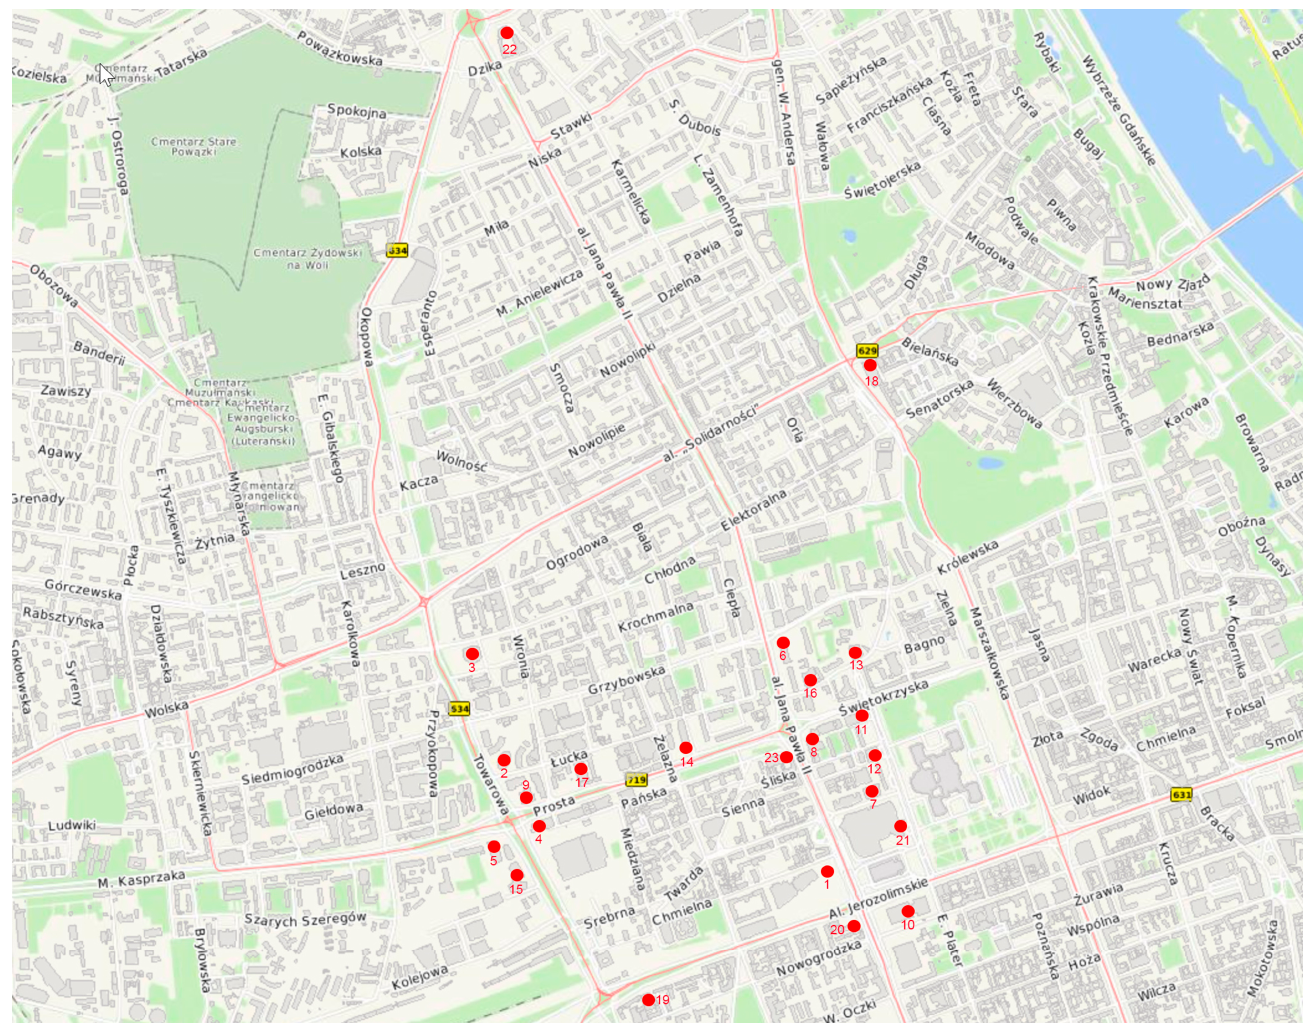
Figure 1. Location of analyzed buildings. Source: author’s study.